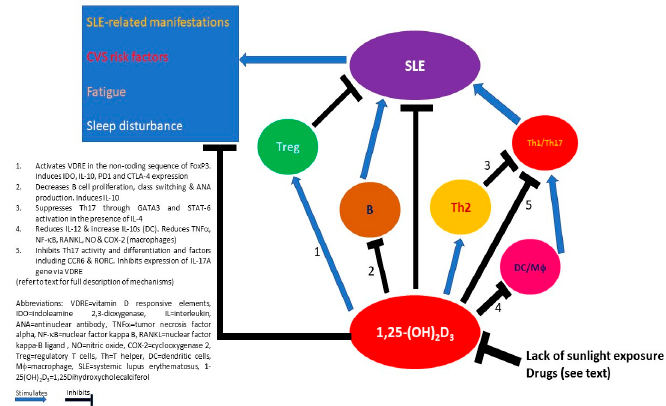
Figure 1. Potential mechanisms of how 1,25-(OH) 2 D 3 interacts with the environment and immune cells in mediating the clinical manifestations of systemic lupus erythematosus (SLE).